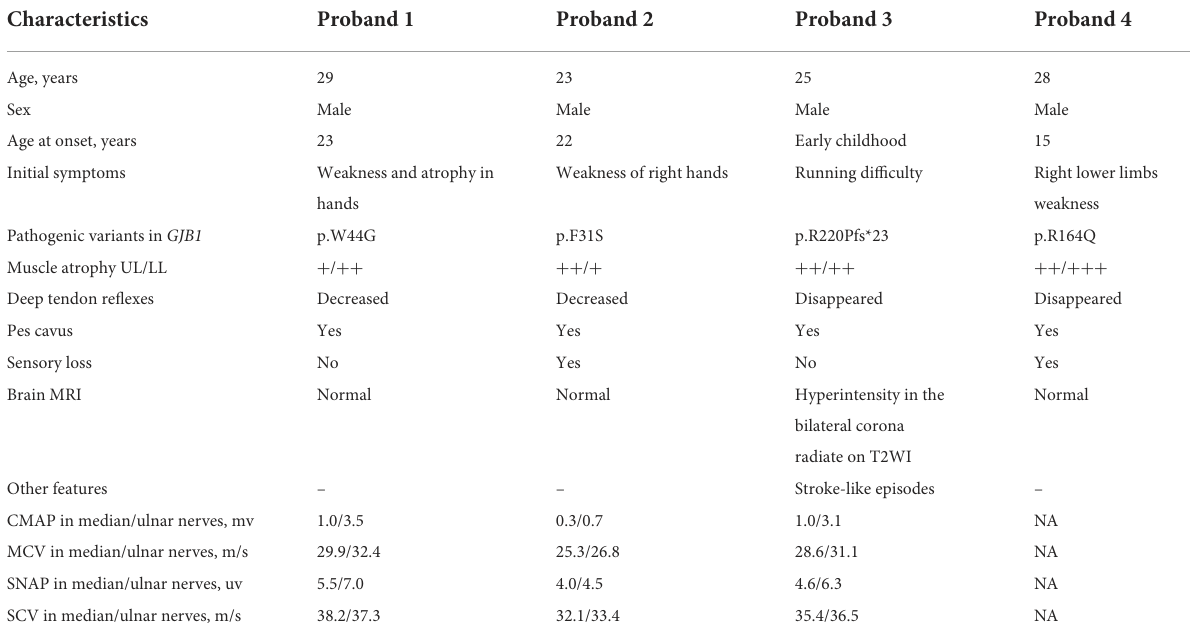
TABLE 1 The clinical presentations and genetic analysis of four CMT